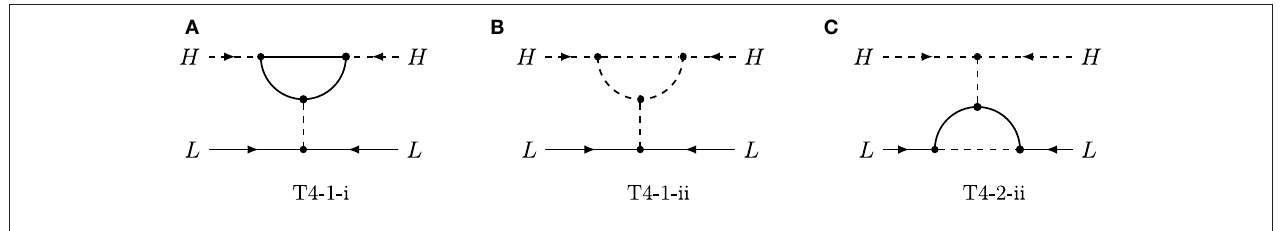
FIGURE 6 | Non-genuine topologies of the Weinberg